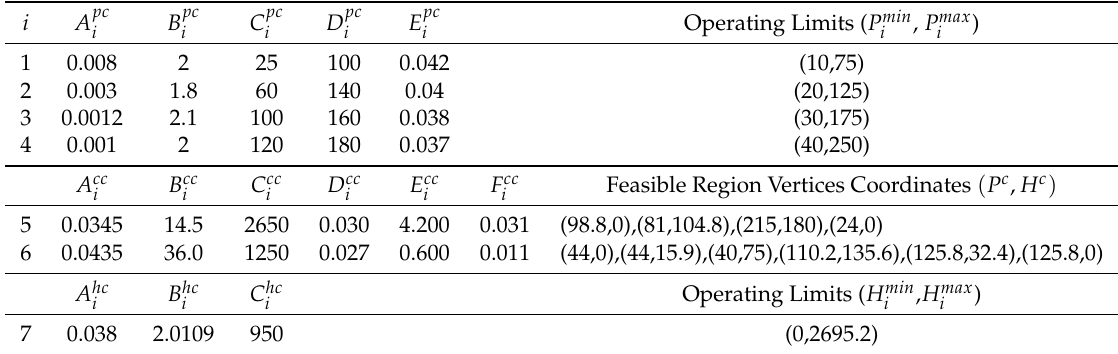
Table A6. Cost functions and operating limits of generating units for test instance 3.